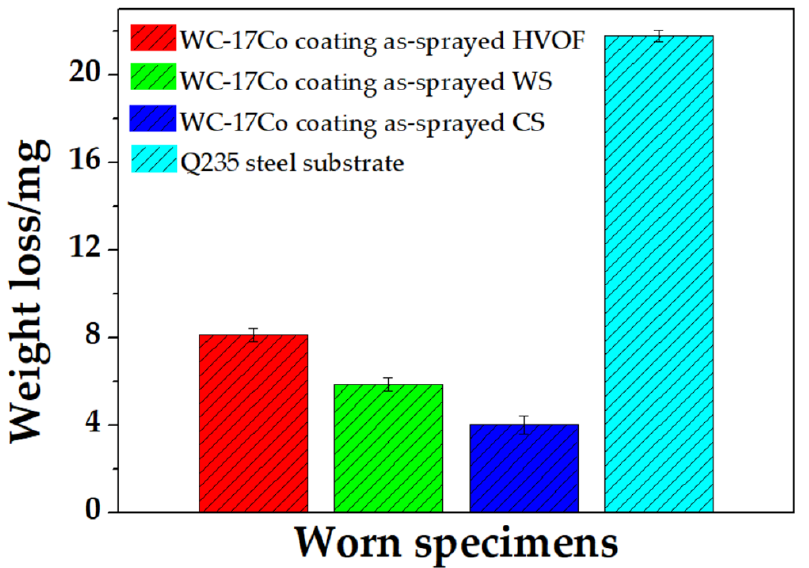
Figure 19. Weight loss of WC-17 coatings formed by various spraying methods and Q235 steel substrate.